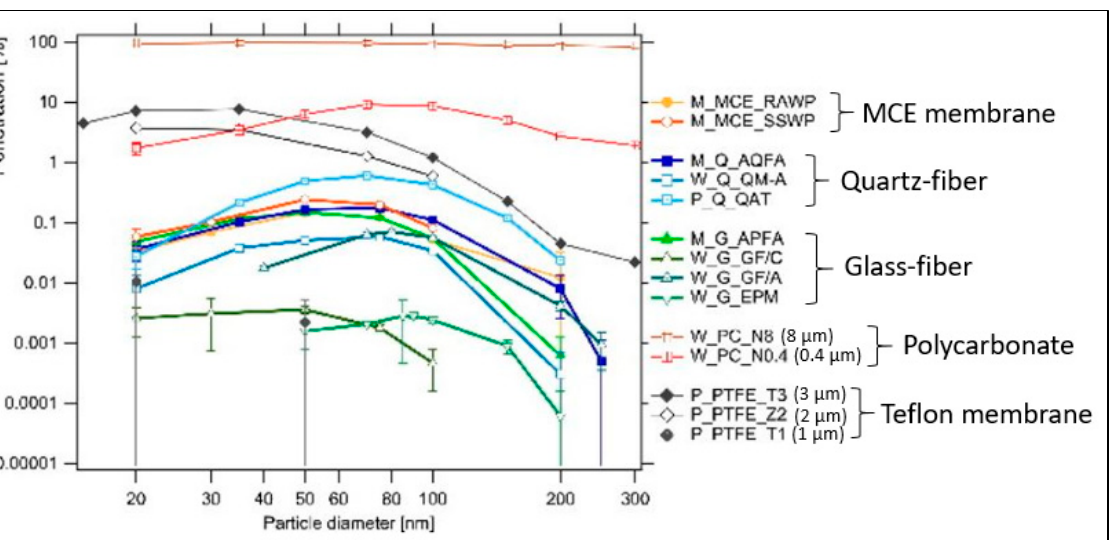
Table 3. Summary of collection efficiency on membrane and capillary pore filters over a range of pore sizes and flow rates [107].